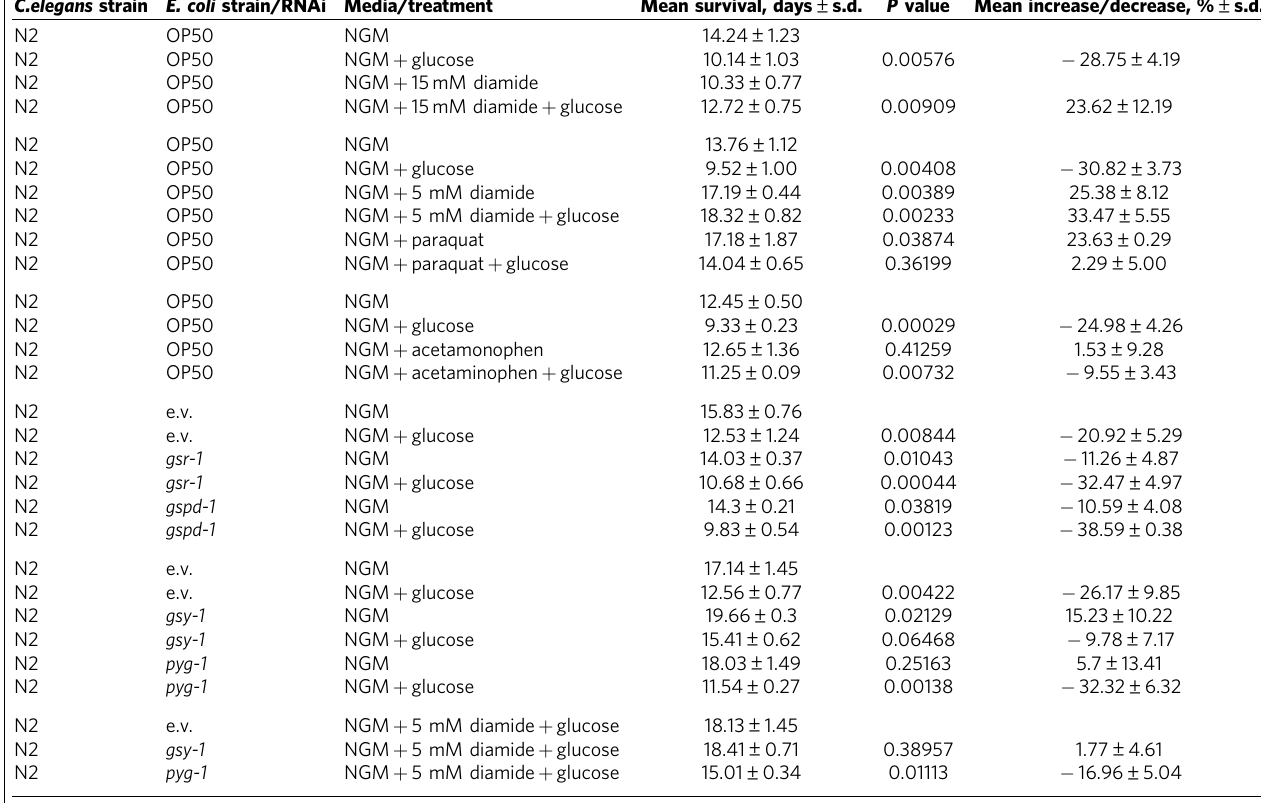
Table 1 | Summary of lifespan experiments with wt C. elegans strains. C.elegans strain E. coli strain/RNAi